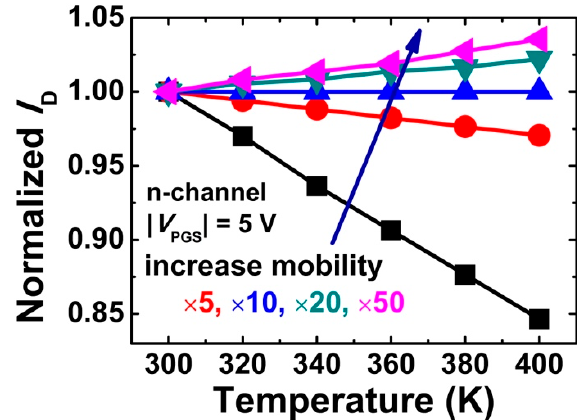
Figure 6. Normalized I ON of n -FET as a function of T with different μ e. The blue arrow shows an increase in the normalized I D due to mobility increasement.